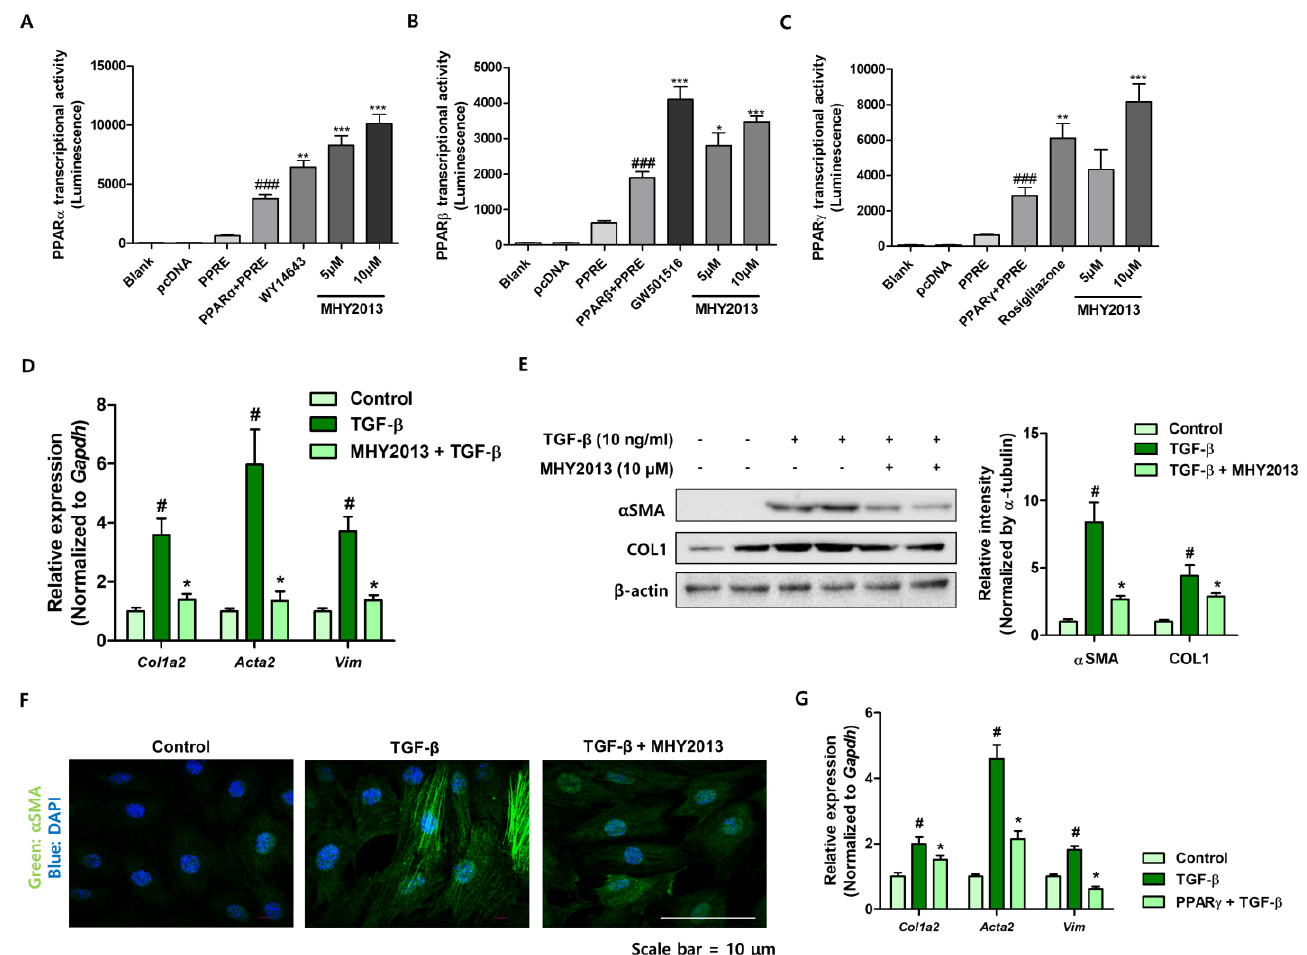
Figure 5. MHY2013 inhibits TGF- β -induced fibroblast activation in NRK49F cells. ( A ) The effect of MHY2013 on PPARα transcriptional activity was measured using the PPRE luciferase system. ### p < 0.001 vs. PPRE group. ** p < 0.005 vs. PPARα + PPRE group. *** p < 0.001 vs. PPARα + PPRE group. ( B ) The effect of MHY2013 on PPARβ transcriptional activity was measured using the PPRE lucif- erase system. ### p < 0.001 vs. PPRE group. * p < 0.05 vs. PPARβ + PPRE gro up. ** p < 0.005 vs. PPARβ